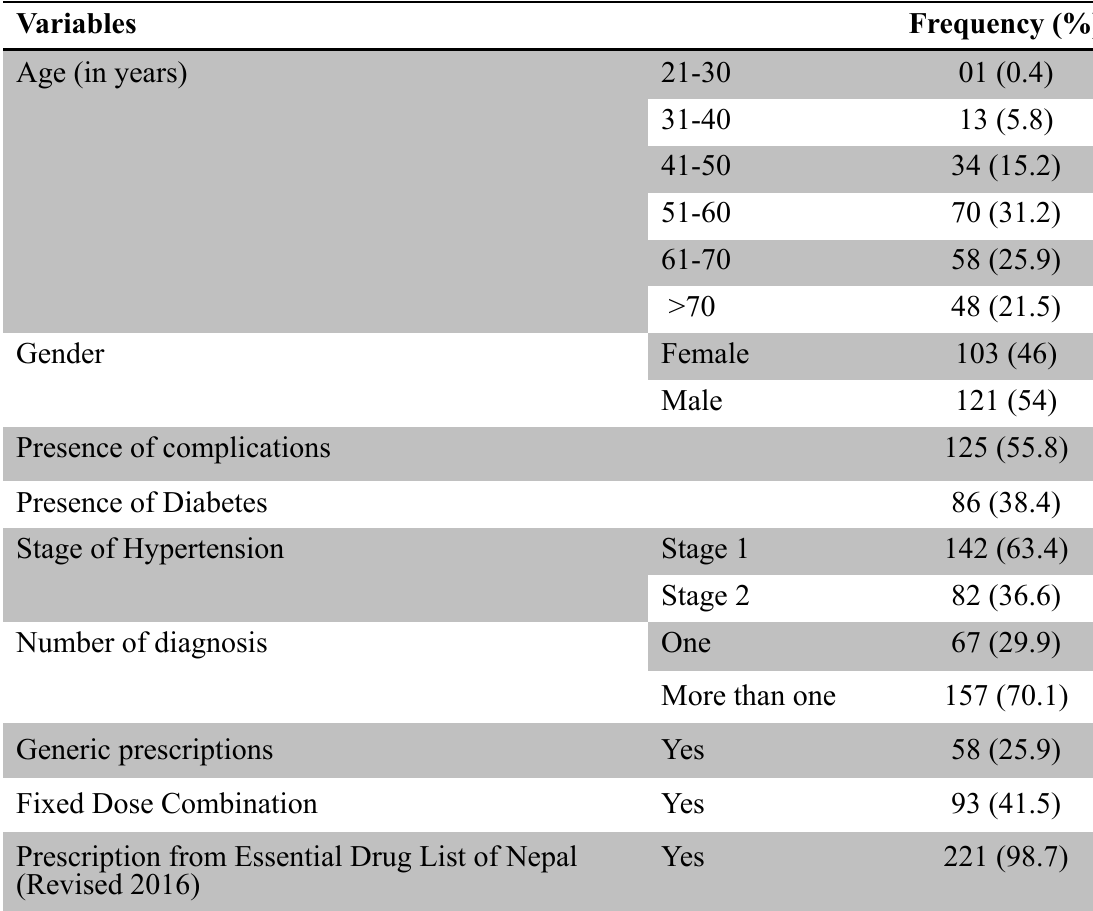
Table 3: Socio-demographic and clinical characteristics of hypertensive patients (N = 224)